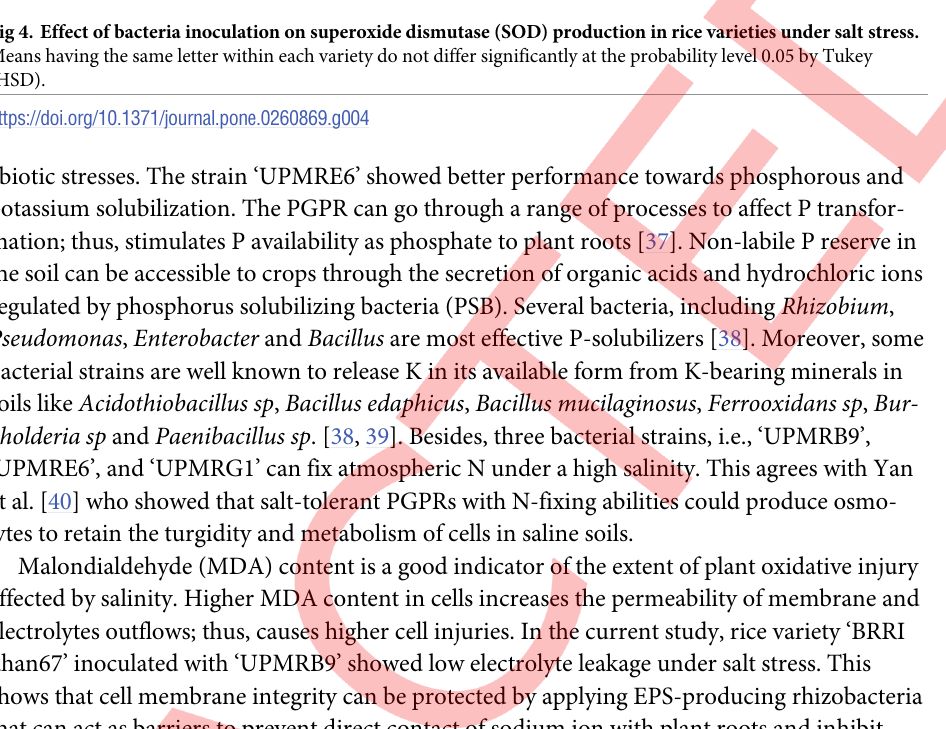
Fig 4. Effect of bacteria inoculation on superoxide dismutase (SOD) production in rice varieties under salt stress. Means having the same letter within each variety do not differ significantly at the probability level 0.05 by Tukey